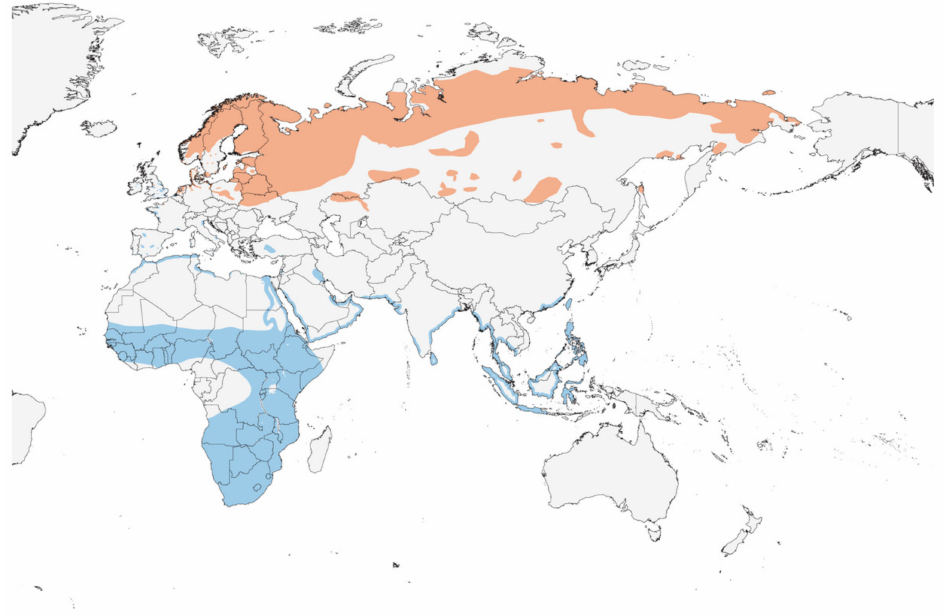
Figure 2. Distribution map of ruff ( Calidris pugnax ) breeding (orange) and wintering (blue) areas [14], © BirdLife